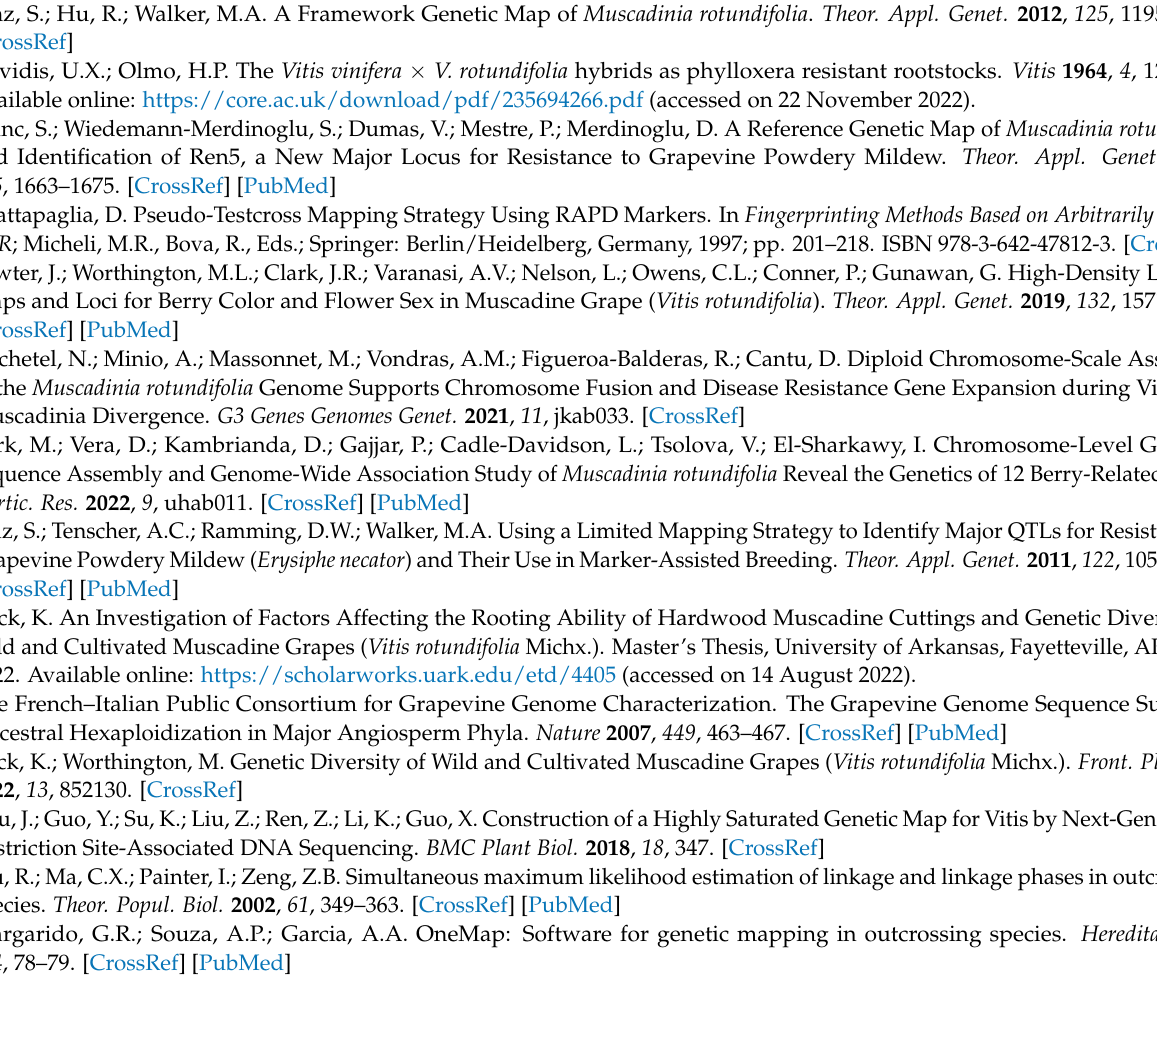
chi-square fit test, Figure S4: The source of fungal conidia to prepare inoculum for the experimental infection of the ‘Dixie’ S1 seedlings: (a) The grape bunches affected by oidium were collected in Livadia (the southern coast of Crimea); (b) leaves, infected by downy mildew collected in the Balaklava region of Crimea. Table S1: 3734 filtered SNPs subjected to linkage mapping, Table S2: The recombination pattern and linkage phases of 3734 SNPs on the genetic map of M. rotundifolia cv.